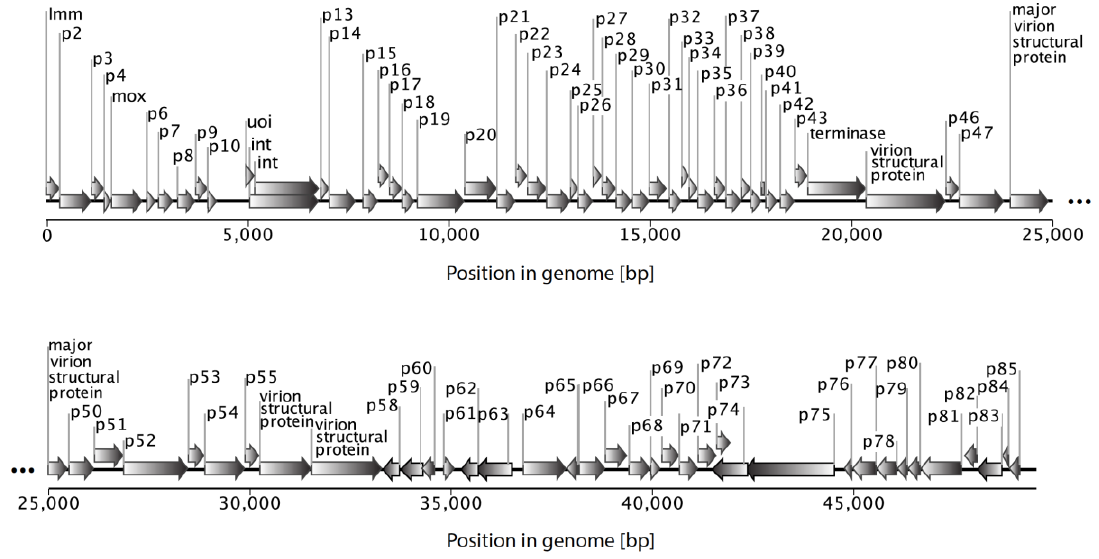
Figure 3. Organization of the myxophage Mx8 genome (size ~49.5 kbp; Genbank ACC # AF396866). Each of the 85 predicted protein-coding genes are depicted by arrows and labelled with connectors.